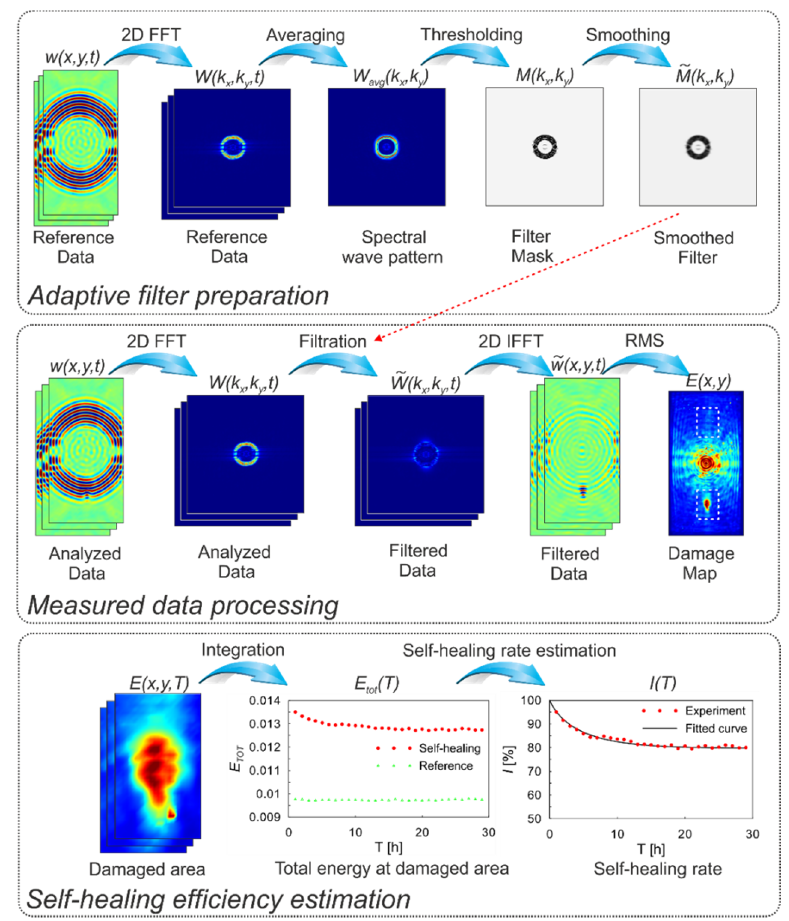
Figure 1. Proposed nondestructive self-healing efficiency estimation method diagram.